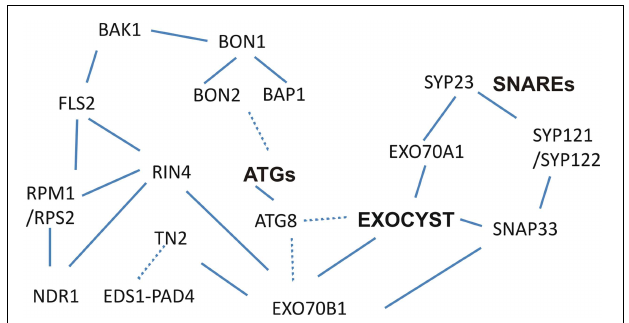
FIGURE 2 | Interactions of PTI, ETI and ATG related proteins with SNAREs and exocyst. The RIN4 interacts with PTI receptor FLS2 and associated proteins, which further interact with BON1, BON2 and BAP. Additionally, RIN4 and related R-proteins may be in the same complex. R proteins and autophagy functions are connected by exocyst and SNARE interactions. (Experimentally confirmed interactions are visualized with lines, non-confirmed with dashed